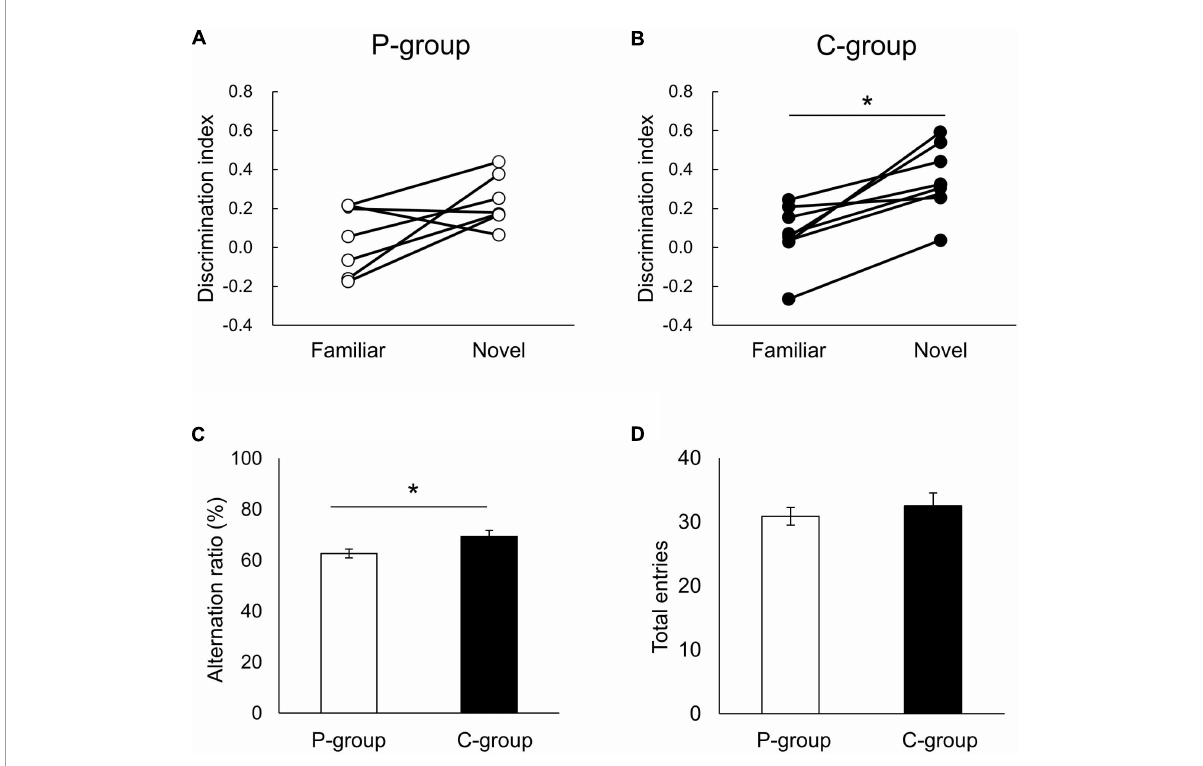
FIGURE2 Effect of mastication on learning ability. (A,B) Result of the novel object recognition test. Significant difference in discrimination index was detected in the C-group between familiar and novel objects ( (cid:63) p < 0.05 by paired t -test). P-group, t (6) = 2.2806, p = 0.0627; C-group, t (7) = 4.6908, p = 0.0022. (C,D) Result of the Y-maze test. C-group rats exhibited significantly larger alternation ratio than P-group rats [ (cid:63) p < 0.05 by t -test, t (14) = 2.2938, p = 0.0378]. No between-group difference was observed in total arm entries [ t (14) = 0.6706, p = 0.5134]. Sample numbers were n = 7 for the P-group (one rat excluded because of slow growth), and n = 8 for the